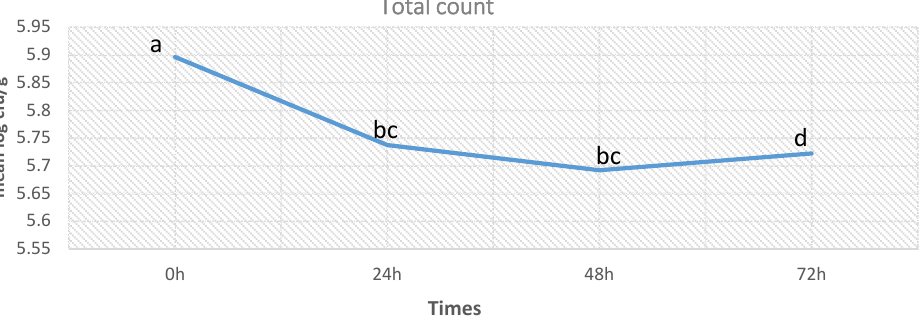
Fig. 1. Comparing mean logarithms of total bacteria count in four hours (zero, 24, 48, 72)